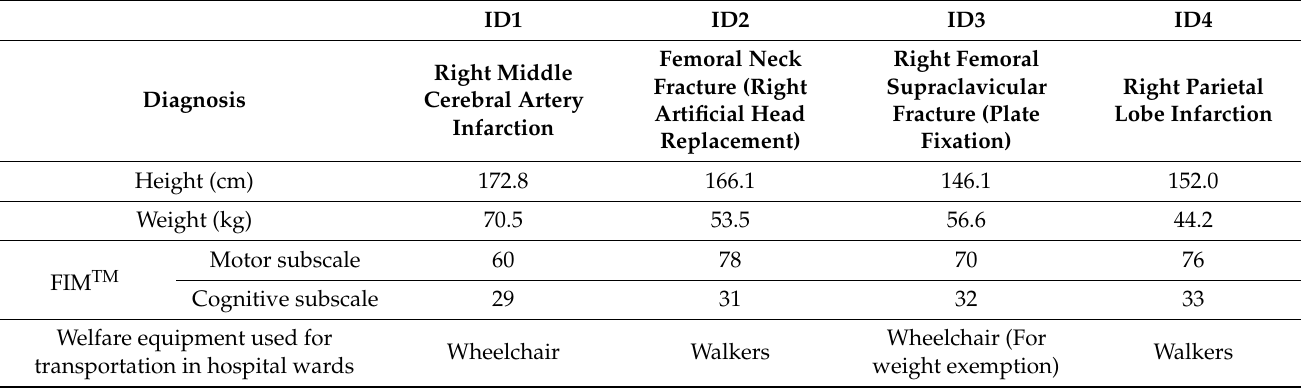
Table 1. Information on patients participating in the present